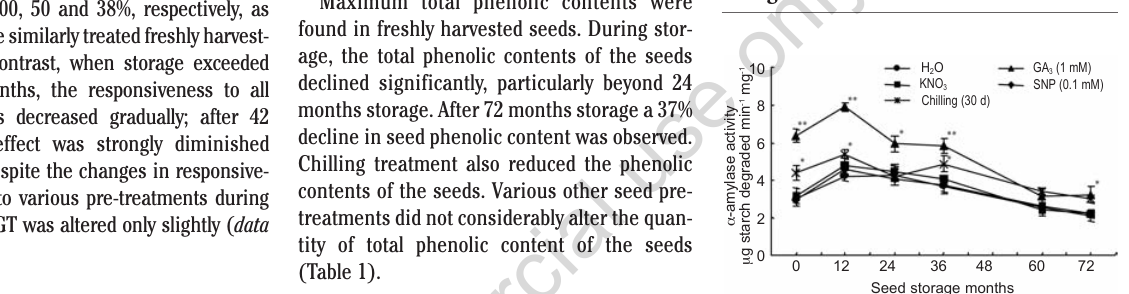
Figure 3. Storage-dependent changes in seed germination and responsiveness to different pre-treatments in H. niger . Data are average of 3 replicates each ± s.d. ASacid scarification; *tested 42 months storage onwards.